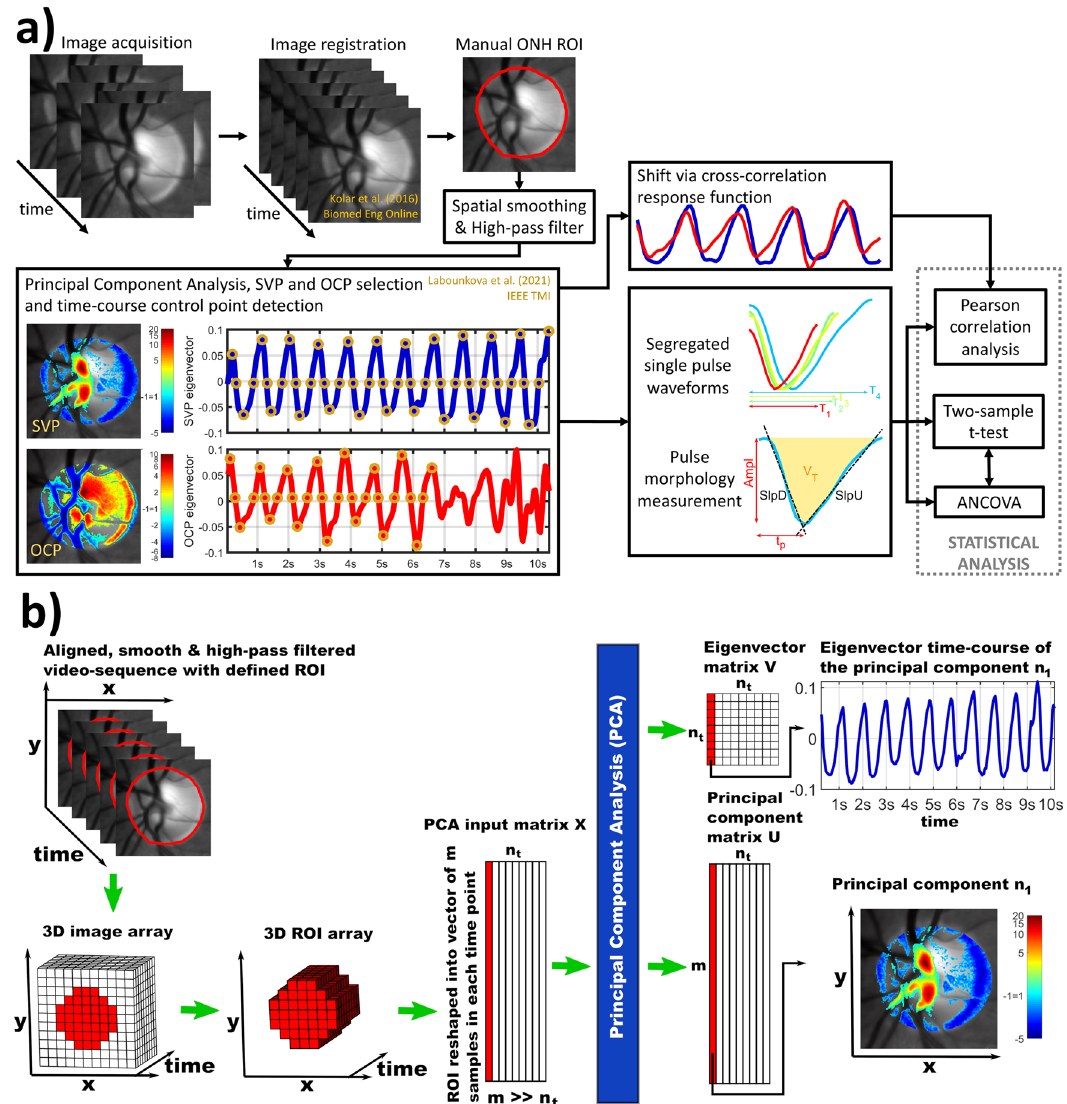
Fig. 1 Image and statistical analysis work fl ow. a The block diagram summarizes the whole image and statistical analysis work fl ow. ONH optic nerve head, ROI region of interest, SVP spontaneous venous pulsation, OCP optic cup pulsation, T period [s], Ampl amplitude, SlpD slope-down, SlpU slope-up, t p time to peak, V T total relative pulse stroke volume, ANCOVA analysis of covariance. b The block diagram summarizes the input-output system of the utilized principal component analysis (PCA). The left input side demonstrates array operations forming the PCA input matrix. The right output side demonstrates temporal and spatial extraction of the results. x, y spatial axes of images, n t total number of time points, m total number of pixels of the ROI in one time point, n 1 index of the principal component number 1 in the output principal component and eigenvector matrices ( fi rst red-highlighted columns), and time point number 1 in the PCA input matrix. Each column in the eigenvector matrix represents an eigenvector time-course of the principal component in the corresponding column of the principal component matrix. In the right bottom corner, the thresholded n1 principal component of m-samples was reshaped back into the original xy space and overlayed the averaged anatomical background image. All images show recordings of the left